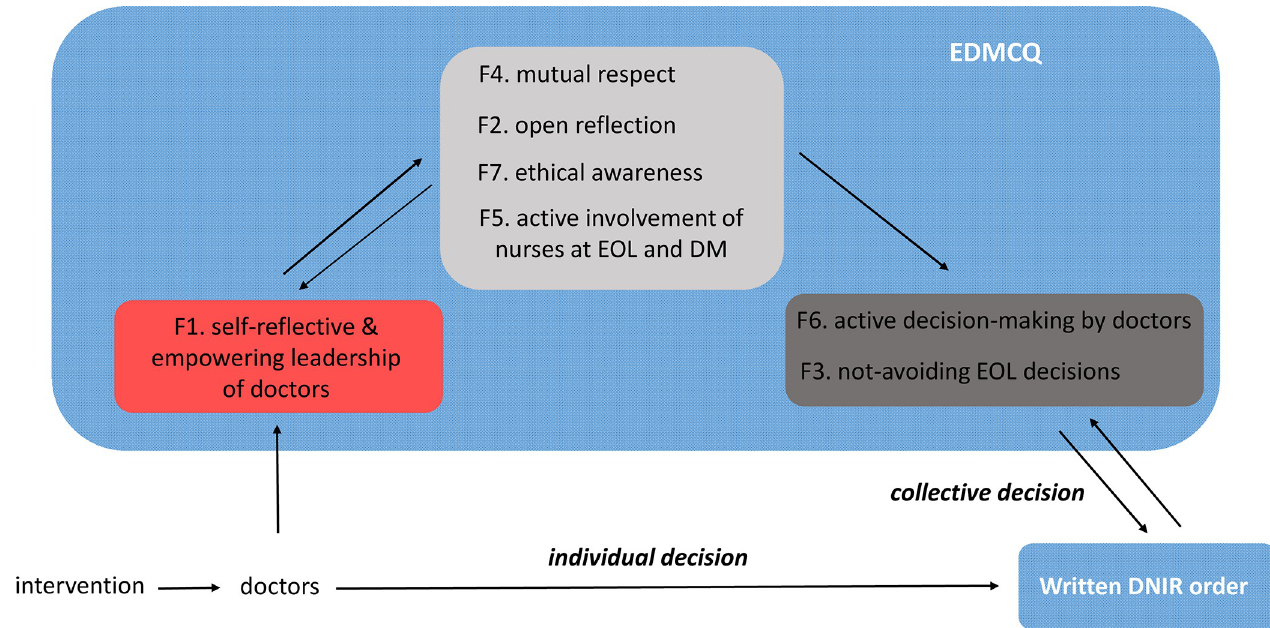
Fig 2. Theoretical background on the primary endpoints. The quality of medical ethical decision-making will be assessed objectively via the incidence of written Do-Not-Intubate and Resuscitate (DNIR) orders in patients potentially receiving excessive treatment during their first hospitalization and subjectively via the Ethical Decision-Making Climate Questionnaire (EDMCQ) [4] that will be filled out by the doctors and nurses in the team one month prior and after the 12-months study period. The EDMCQ is 32-item validated questionnaire consists of 7 main domains or factors: factor F1 “self-reflective and empowering leadership of doctors”, F2 “open and interdisciplinary reflection”, F3 “not avoiding end-of-life decisions”, F4 “mutual respect within the interdisciplinary team”, F5 “active involvement of nurses in end-of-life care and decision-making”, F6 “active decision-making by doctors”, F7 “ethical awareness”. We expect that an effect on individual decision-making by doctors would affect the incidence of written DNIR orders both directly, and indirectly via F3 and F6. We expect that effect on collective decision-making in team would affect F1, which in turn affects all other EDMCQ factors and via these, the incidence of written DNIR orders. Both null hypotheses that will be tested express no change (as opposed to